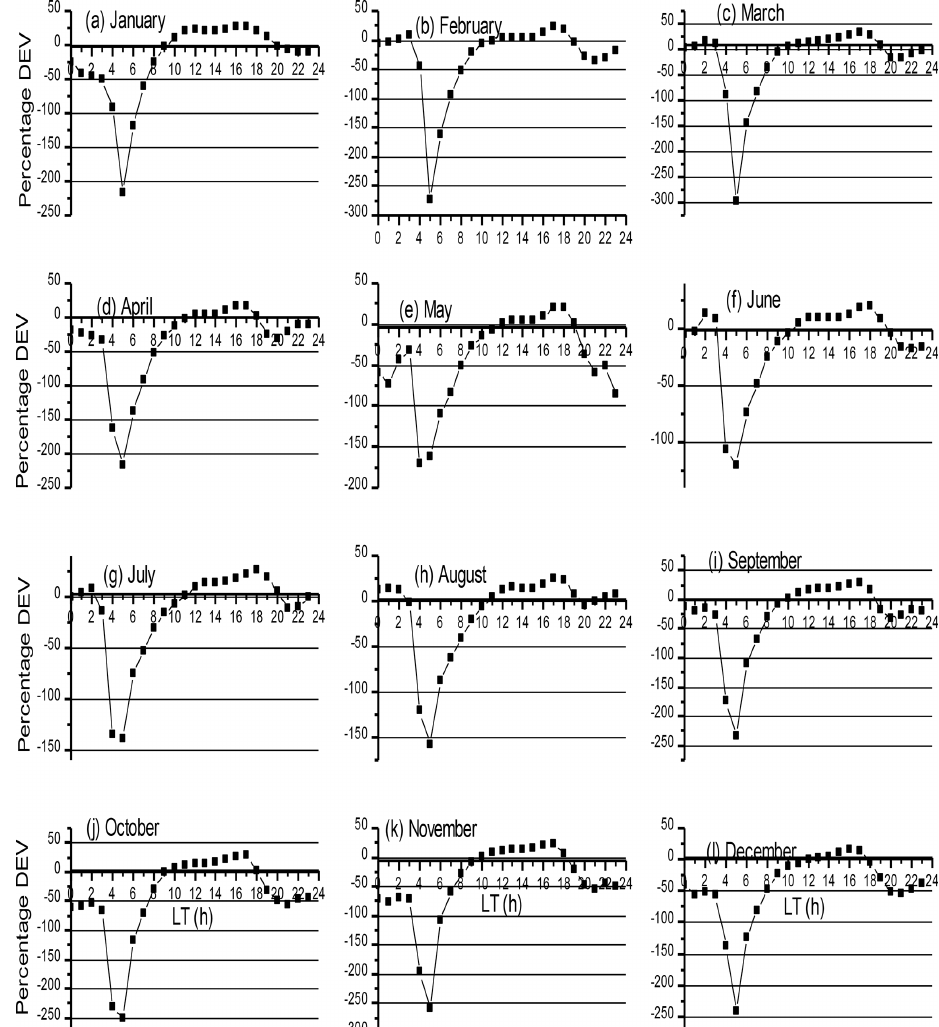
Figure 6. Percentage deviation of IRI-2016 from OBS-TEC for year